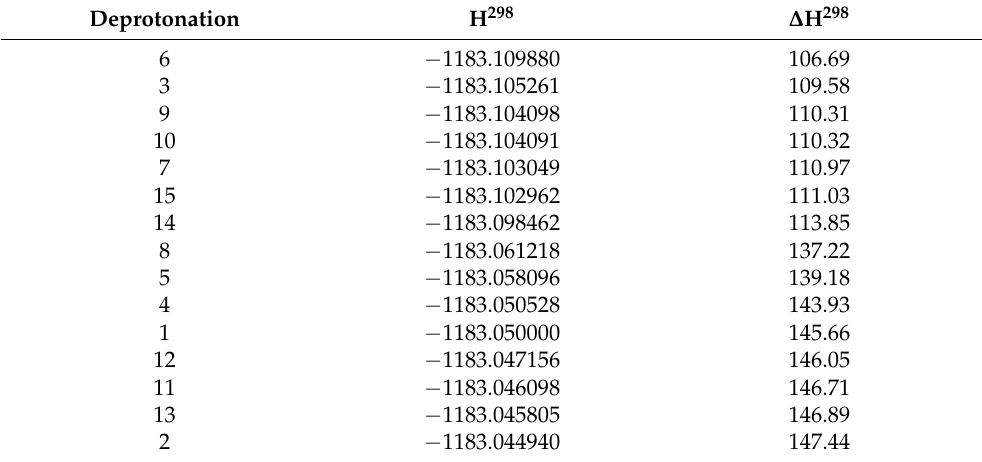
Table 1. The H 298 (in hartree) of armodafinil anions and ∆ H 298 of deprotonation reaction (kcal/mol). The most energetically effective deprotonation position is marked with red font.